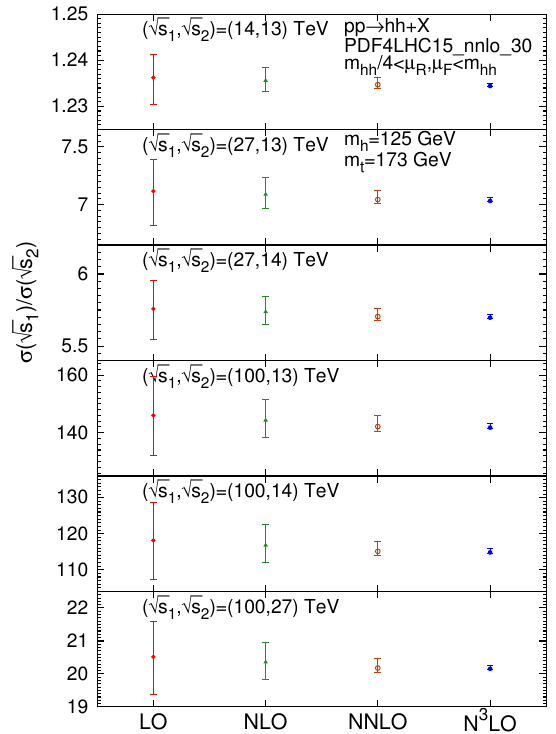
p s for the Higgs boson pair production